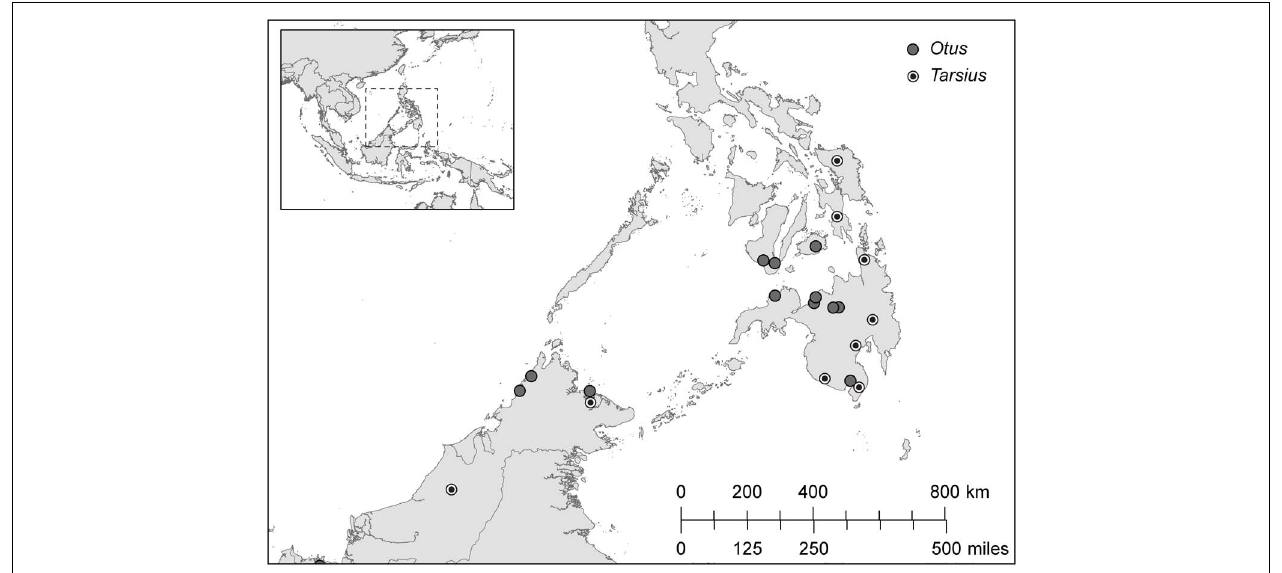
FIGURE 4 |The distribution of sampling localities in Borneo ( Otus lempiji and Tarsius bancanus ) and in Philippines ( O. megalotis and T. syrichta ).